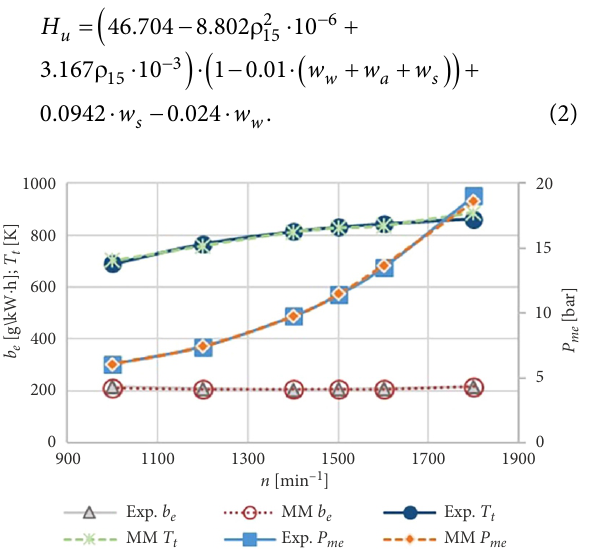
Figure 2. Caterpillar 3512B experimental data and MM specific fuel consumption b e , exhaust gas temperature T , and mean effective pressure P me readings